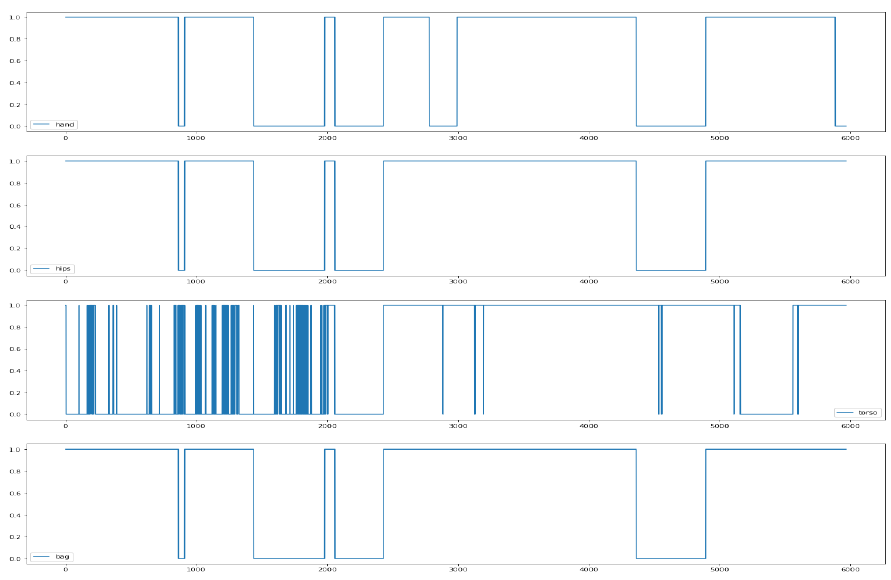
Figure 9. Example of clustered data for all four locations (from top to bottom: hand , hips , torso , and bag ) for walking. The clustering is applied in the same manner as that for all other activities.